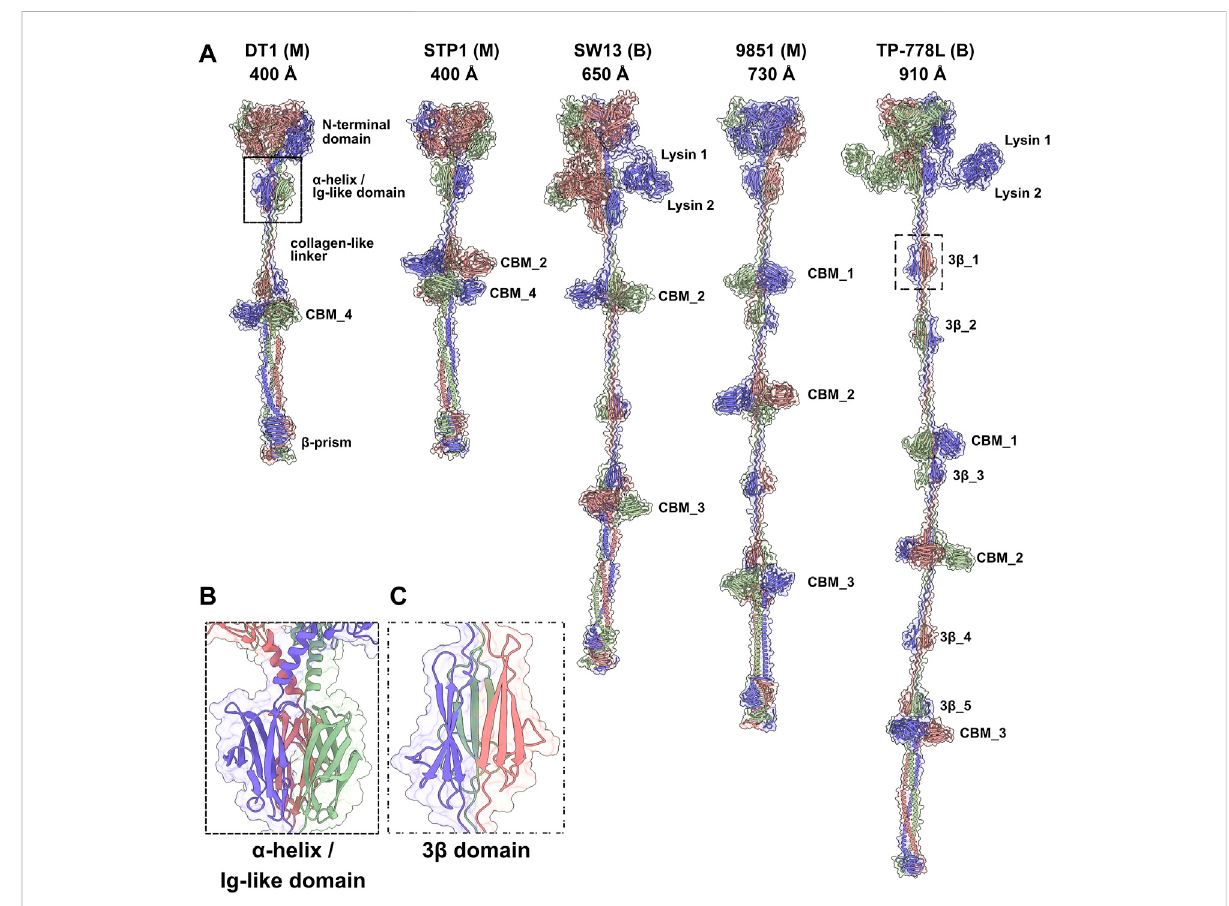
FIGURE 2 Predicted structures ofTals. (A) Ribbonandtransparentsurfacerepresentations oftrimericTals(coloredbychain) fromthe fi ve S.thermophilus phages.ThevariousdomainsareindicatedaslistedinTable1.JunctionsbetweenN-terminalstructuraldomainsandC-terminalextensionswerenot reliably predicted, therefore we did not join them in our structural models. (B) Close-up view on the α -helix and Ig-like domain that follow the Tal N-terminal structural domain. (C) Close-up view on a 3 β